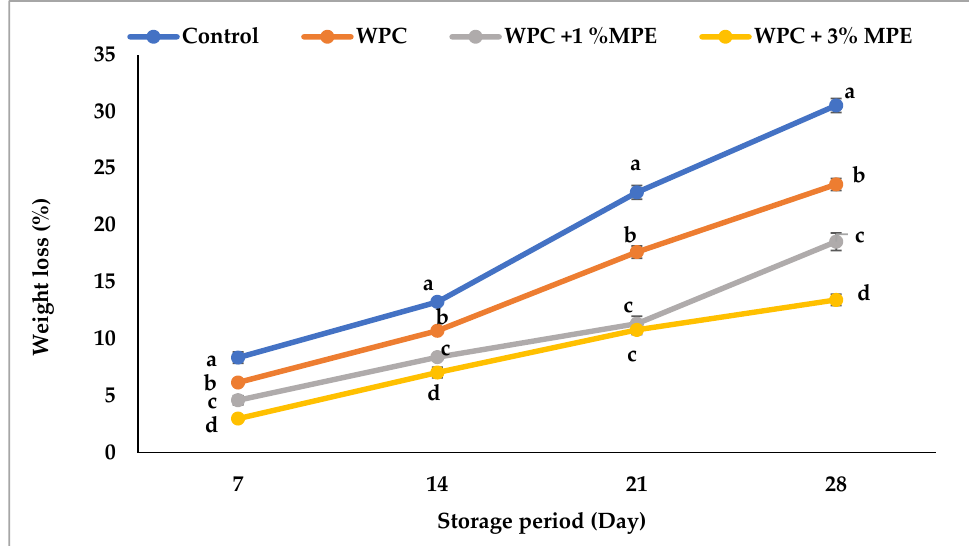
Figure 1. Effect of whey protein concentrate combined with mango peel extract (WPC = whey protein concentrate alone, WPC + 1% MPE = whey protein concentrate + mango peel extract at 1% and WPC + 3% MPE = whey protein concentrate + mango peel extract at 3%) on weight loss percentage of broccoli fresh-cuts at 5 °C. Vertical bars indicate standard deviation (n = 6). Means and different letters indicate significant difference between treated and control broccoli for each storage period (Duncan’s multiple range test at 95%).